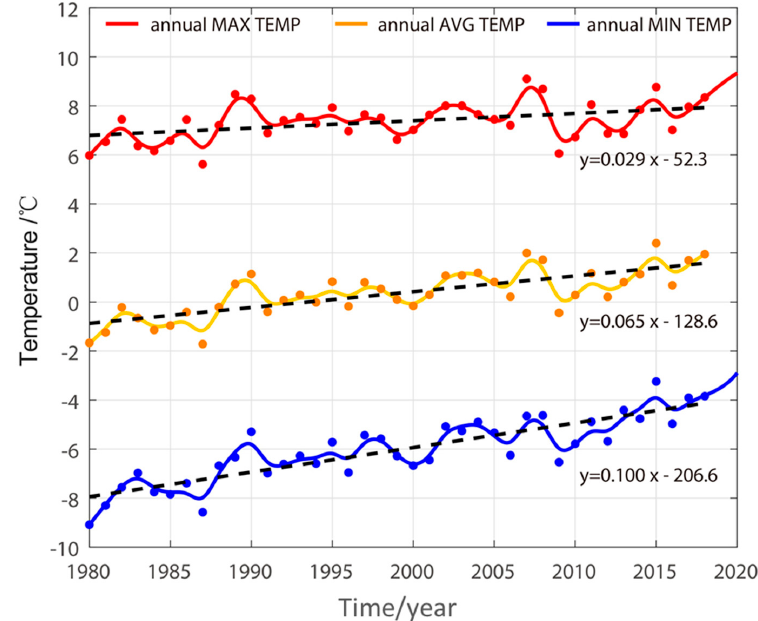
Figure 2. The annual air temperature of Sunwu County, Heilongjiang Province, China, from 1980 to 2018. The spatial distribution of island permafrost in the study area is highly variable and discrete.